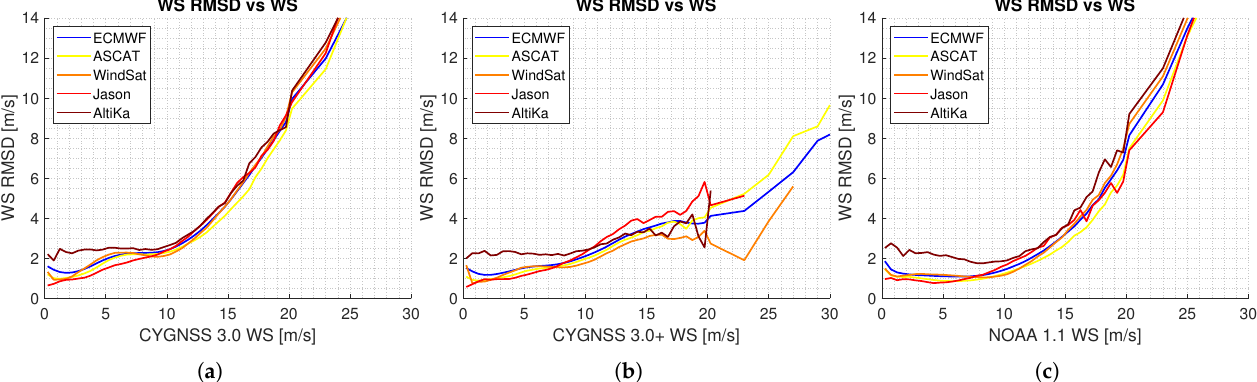
Figure 7. RMSD of the wind speed from different products vs the wind speed of different CYGNSS estimates: ( a ) CYGNSS SOC FDS MV 3.0, ( b ) CYGNSS SOC FDS MV 3.0 with SWH correction, and ( c ) OSWT